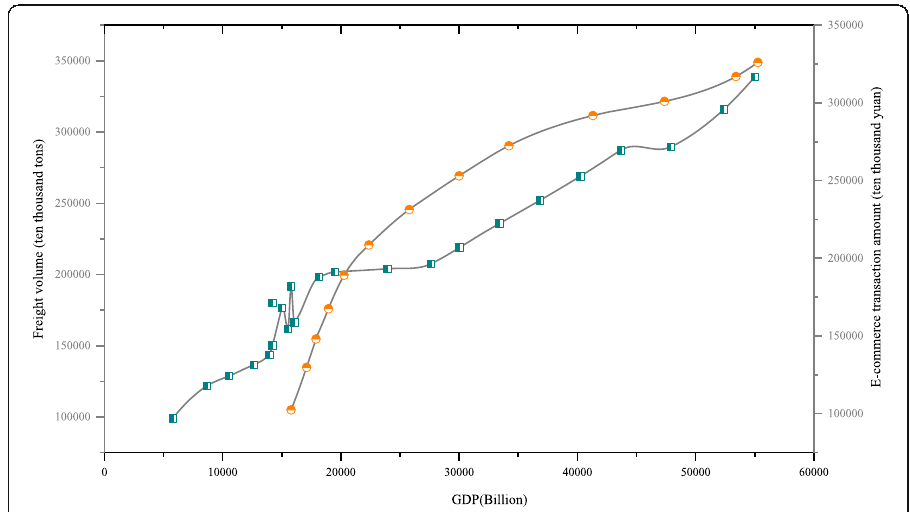
Fig. 5 Relationship between e-commerce transaction volume and freight